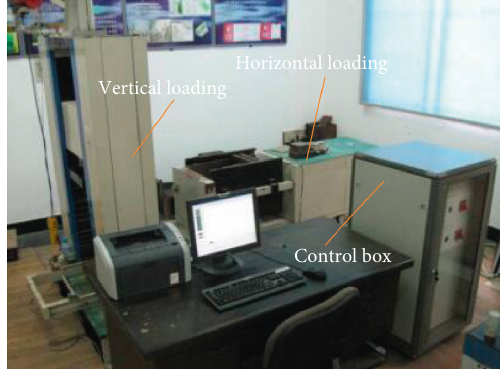
Figure 4: Direct shear instrument for